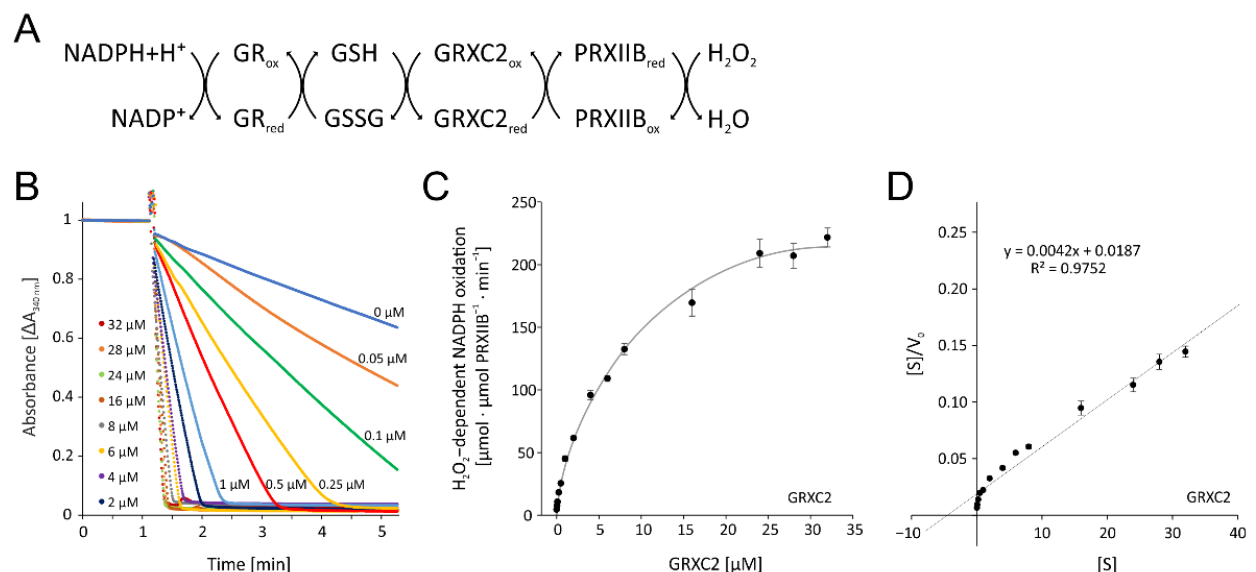
Figure 8. Optimization of the peroxiredoxin IIB-dependent peroxide detoxification assay using the reconstituted system. ( A ) Scheme of the reaction sequence. ( B ) Representative spectroscopic recordings matched to the time point of H 2 O 2 addition and similar baselines of GRXC2 concentration-dependent reduction of H 2 O 2 by 3 µ M PRXIIB. The assay contained 200 µ M NADPH, 1 µ M GR, 2 mM glutathione, 3 µ M PRXIIB, 300 µ M H 2 O 2 and variable GRXC2 concentrations as indicated. The initial linear rate was used for quantification. ( C ) GRXC2 concentration dependency of H 2 O 2 reduction by PRXIIB. ( D ) Hanes–Woolf plot of PRXIIB and 0.05–32 µ M GRXC2 as electron donor according to ( C ). Data are means ± SD of n = 6 ( C , D ).